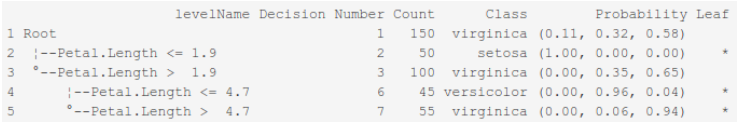
Figure 8. Final tree structure using fully automated learning and a misclassification cost matrix for the Iris data set.